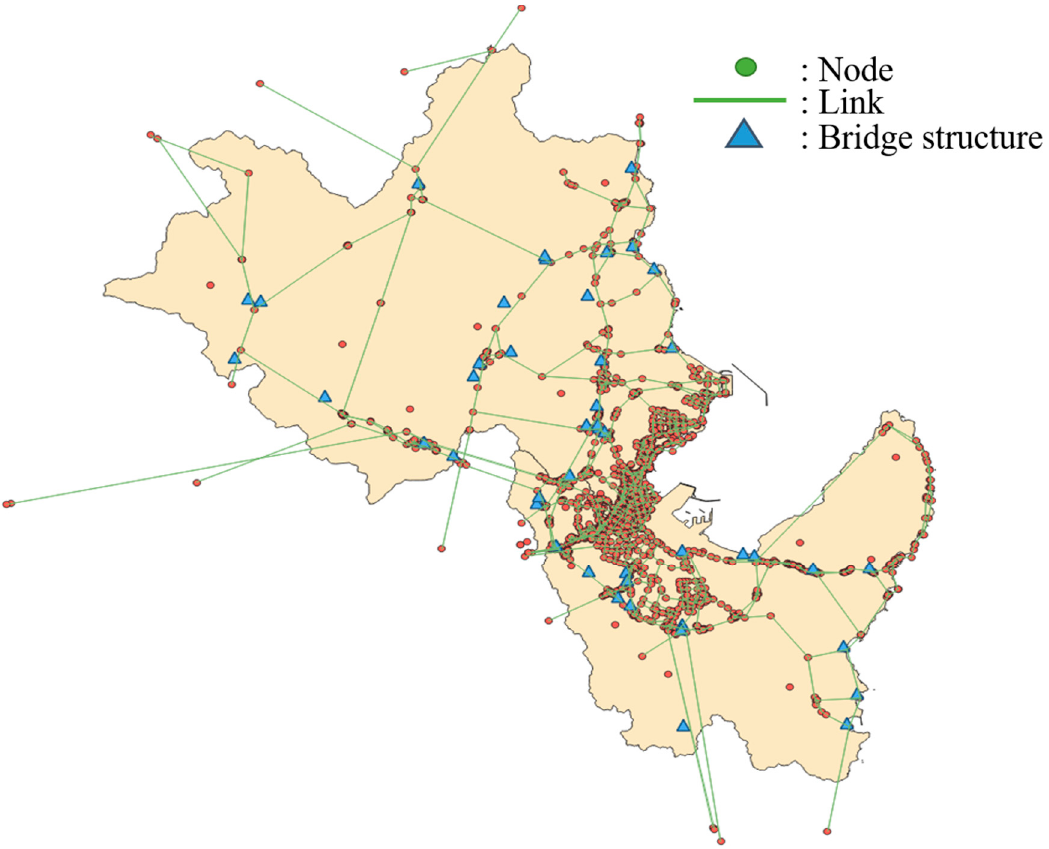
Figure 3. Reconstructed target bridge transportation network.